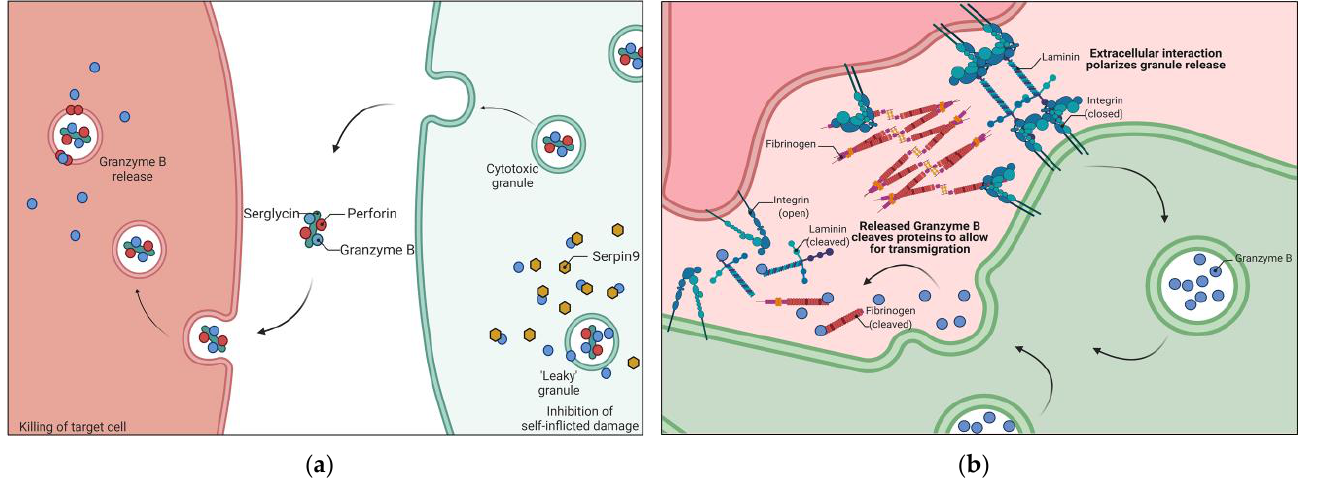
Figure 1. Schematic representation of canonical and non-canonical features of Granzyme B (GzmB). ( a ) Targeted killing of cancer cells by T cells through granule release while inhibiting self-inflicted damage caused by leaky granules. GzmB is introduced into a target cell leading to apoptosis. GzmB leaked into T cells is inhibited by Serpin9. ( b ) Extracellular interaction polarizes granules for release, resulting in cleavage of extracellular factors such as fibrinogen and laminin. These cleavages increase the rate of transmigration of T cells. Serpin9 = Serine Protease Inhibitor 9.